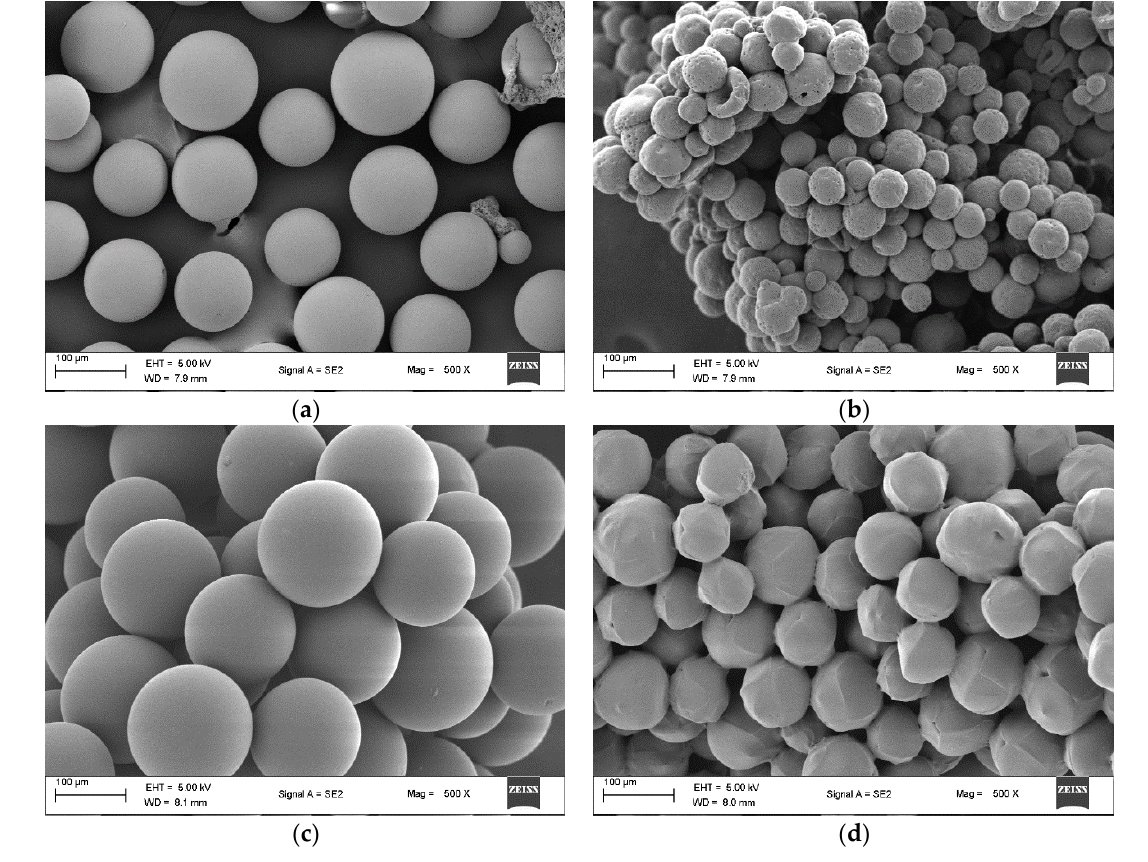
Figure 3. SEM images of ( a ) PS, ( b ) PEG-PS, ( c ) CLEAR, and ( d ) CM taken at 100 µm and magnifi- cation of 500. of